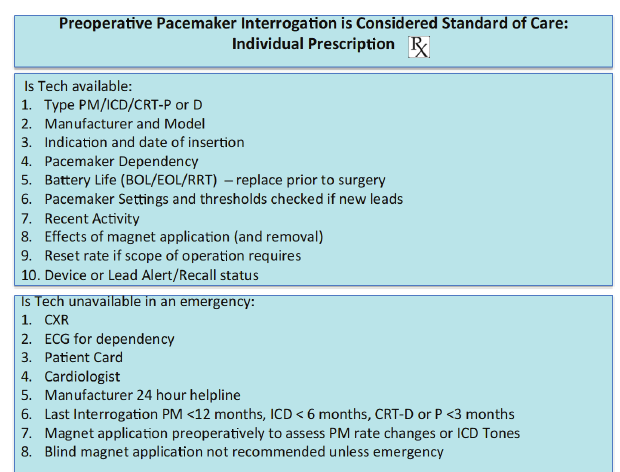
Figure 4. Preoperative Pacemaker and ICD Interrogation